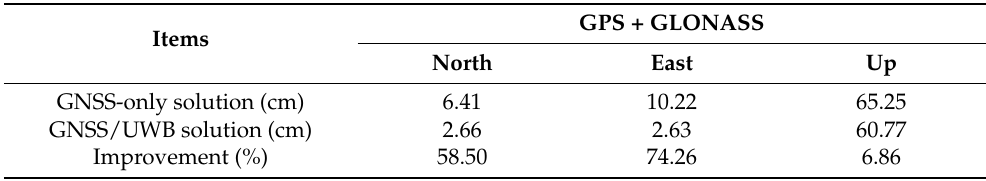
Table 2. RMS values of the positioning errors for GNSS/UWB and GNSS-only solutions with a cutoff elevation angle of 40 ◦